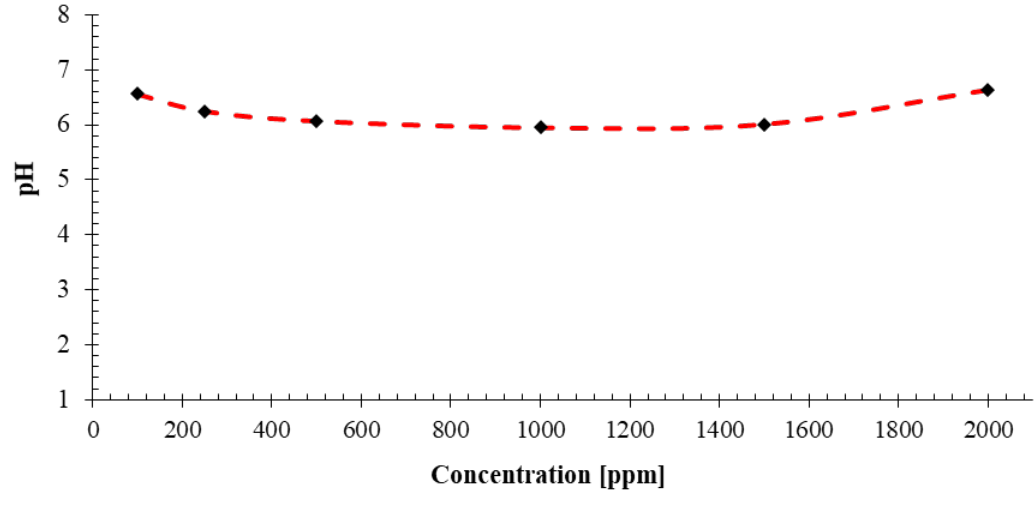
Figure 9. pH values determined for the nanofluids prepared using di ff erent concentrations of the novel Figure 10. Viscosity values determined for the nanofluids prepared using different concentrations of NC (100–2000 ppm). pH of the prepared nanofluids is almost insensitive to changes in concentration of the novel NC (100–2000 ppm). The viscosity of the prepared nanofluids is almost constant at different the novel concentrations of the novel NC.